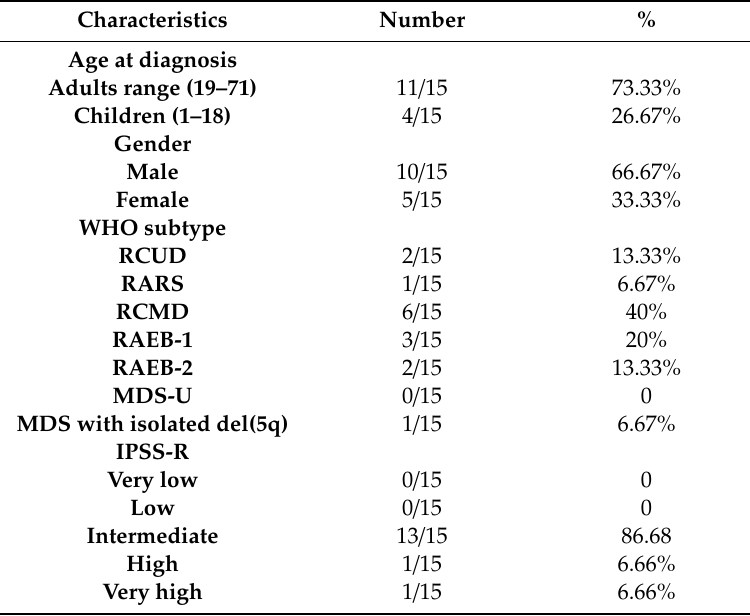
Table 1. Baseline characteristics of all MDS